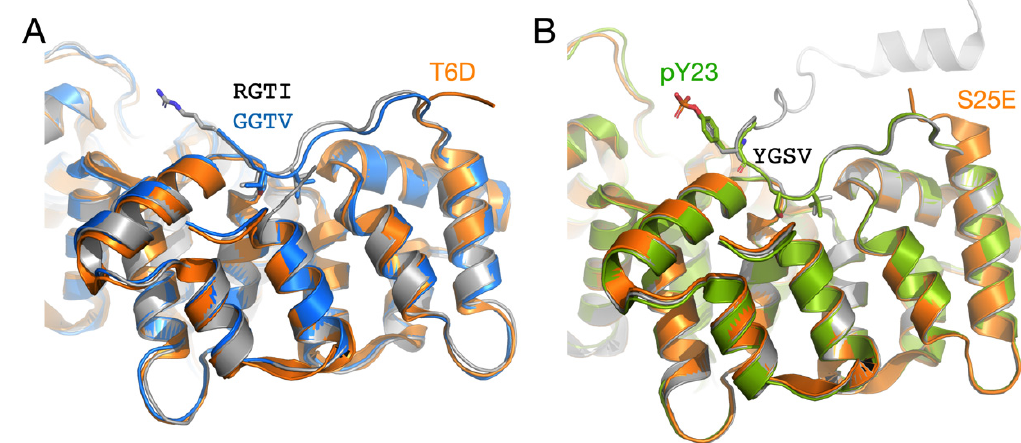
Figure 4. Regulation of the RGTI motif via phosphorylation in other annexins. ( A ) Comparison of AnxA11 (grey) with AnxA4 (blue) [49]. The structure of the phosphomimicking AnxA4 T6D mutant [61] is shown in orange and has an open conformation. ( B ) Three states of AnxA2 [56]. The nonphosphorylated protein is in grey, AnxA2 phosphorylated on Tyr23 in green, and the open conformation of S25E in orange.